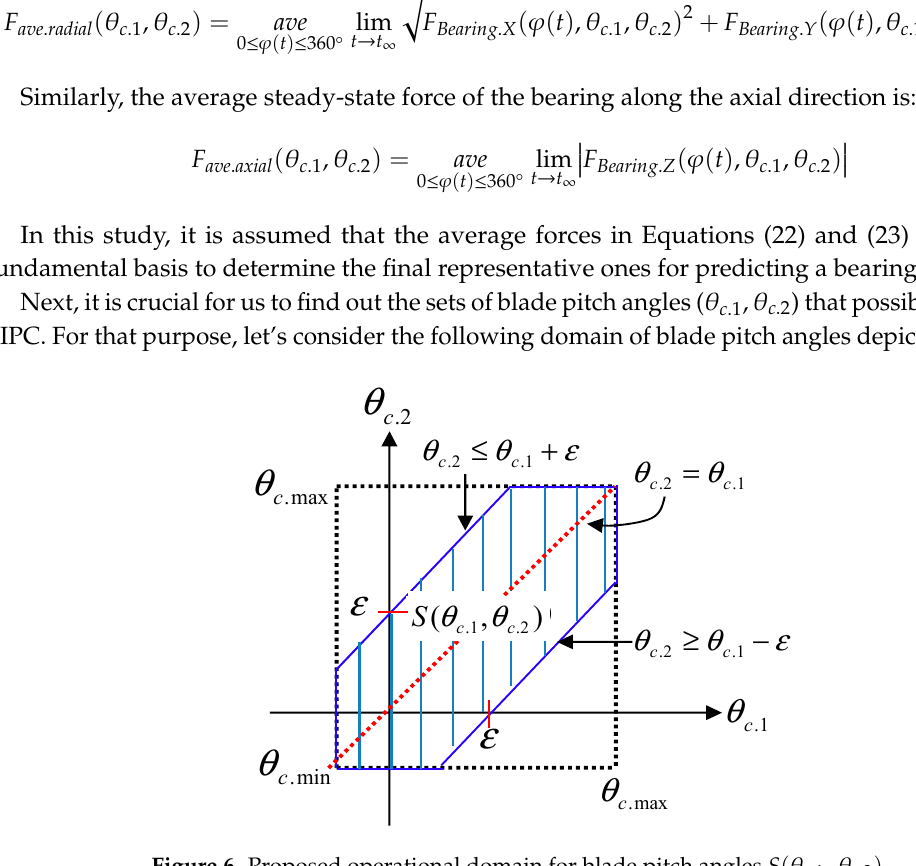
Figure 6. Proposed operational domain for blade pitch angles S ( θ c .1 , θ c .2 )